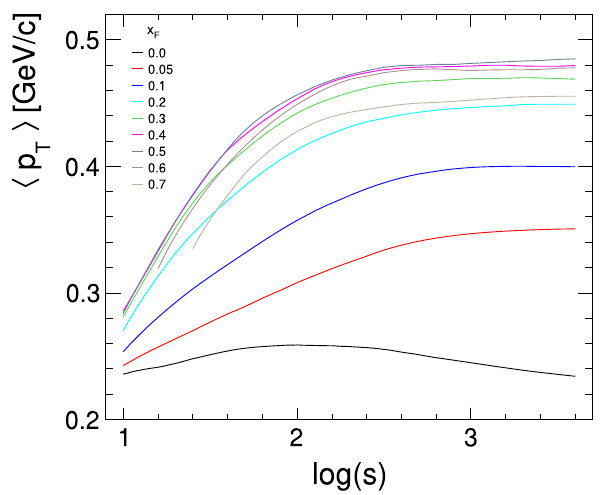
Fig. 177 (cid:4) p T (cid:5) of π − as a function of log ( s ) for several values of x F The saturation in log ( s ) is due to two underlying effects. Firstly the invariant cross sections show only a small s - dependence above log ( s ) = 2.5, see Fig. 130 for p T = 1.3 GeV/c. Secondly the limit at p T < 1.3 GeV/c leaves the tail of the p T distributions unaccounted for. The effect of this p T cut is shown in Fig. 178 where the percentage increase of (cid:4) p T (cid:5) from an upper limit at 1.3 GeV/c to an upper limit at 1.9 GeV/c is presented.